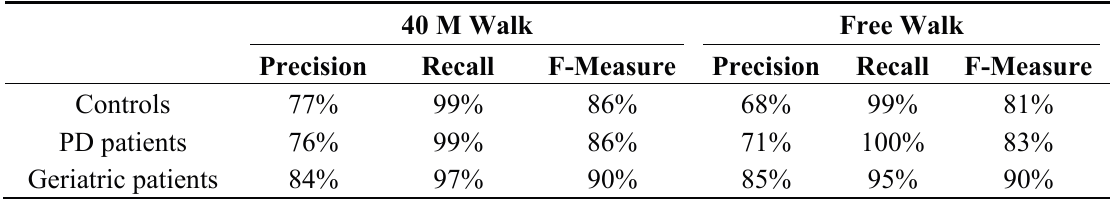
Figure 8. Excerpt of a typical gait signal from free walk of an elderly control. The subject climbed stairs for the first 20 s, which was followed by a transition to a straight walking episode. In the upper plot ( A ) manually labeled strides were marked with red crosses and the complete gait sequence in dark grey. The middle plot ( B ) shows the result from msDTW with recognized strides marked with red crosses and segmented gait sequence marked in grey. Lower plot ( C ) shows marked strides from peak detection algorithm. Only stride maxima were marked with red crosses, because peak detection only detects the peaks, not the complete gait sequence. Bottom plot also shows typical mistakes from the peak detection algorithm, where stair climbing strides by mistake were marked as strides. Table 4. Detailed results of 4 0 m walk and free walk from peak detection algorithm based on data from GZ. The evaluated data corresponds to msDTW evaluated Section